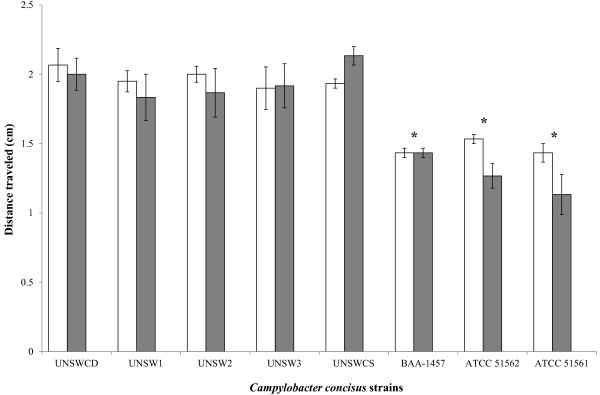
The motility of Campylobacter concisus strains following growth in solid (white) and liquid (gray) media. Vertical lines associated with histogram bars represent standard error of the mean. * implies p<0.05.